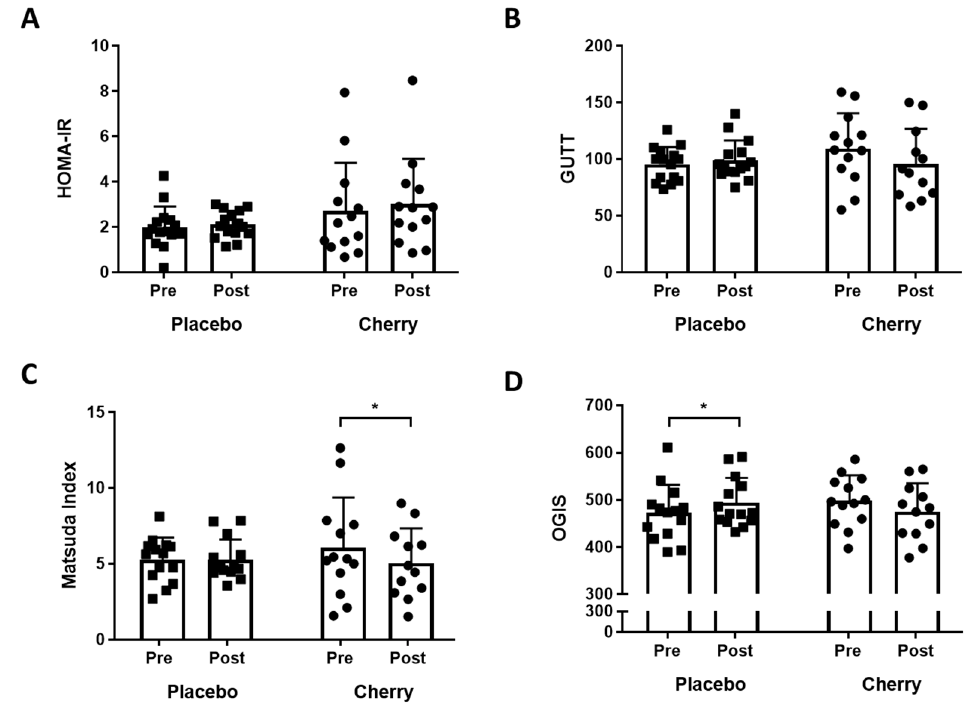
Figure 2. Indices of Glucose Tolerance and Insulin Sensitivity in Placebo and Montmorency Cherry Supplemented Middle-Aged Participants. A total of 28 non-obese middle-aged men and women (40–60 years) consumed a daily dose of Montmorency cherry concentrate ( n = 13) or an equivalent volume of glucose and energy-matched placebo ( n = 15) for 4 weeks. An oral glucose tolerance test was conducted pre- and post-supplementation and surrogate measures of insulin sensitivity were calculated. ( A ) HOMA-IR = Homeostatic model assessment insulin resistance; ( B ) the Gutt index of insulin sensitivity; ( C ) Matsuda index; ( D ) OGIS = Oral Glucose Insulin Sensitivity Model. * p < 0.05. Missing data points are due to failure of venous access at a necessary timepoint. Black squares = placebo, black circles = cherry.